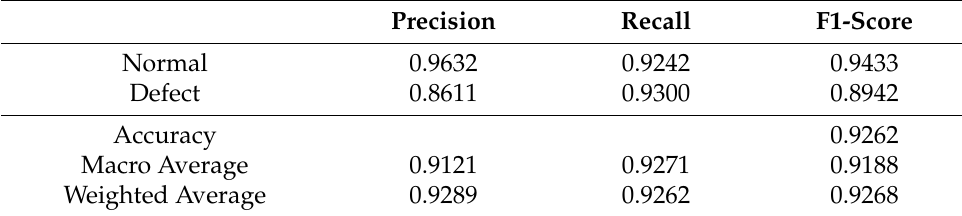
Table 7. Results of Case